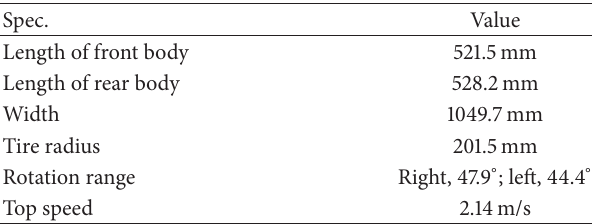
Table 1: Characteristics of articulated vehicle